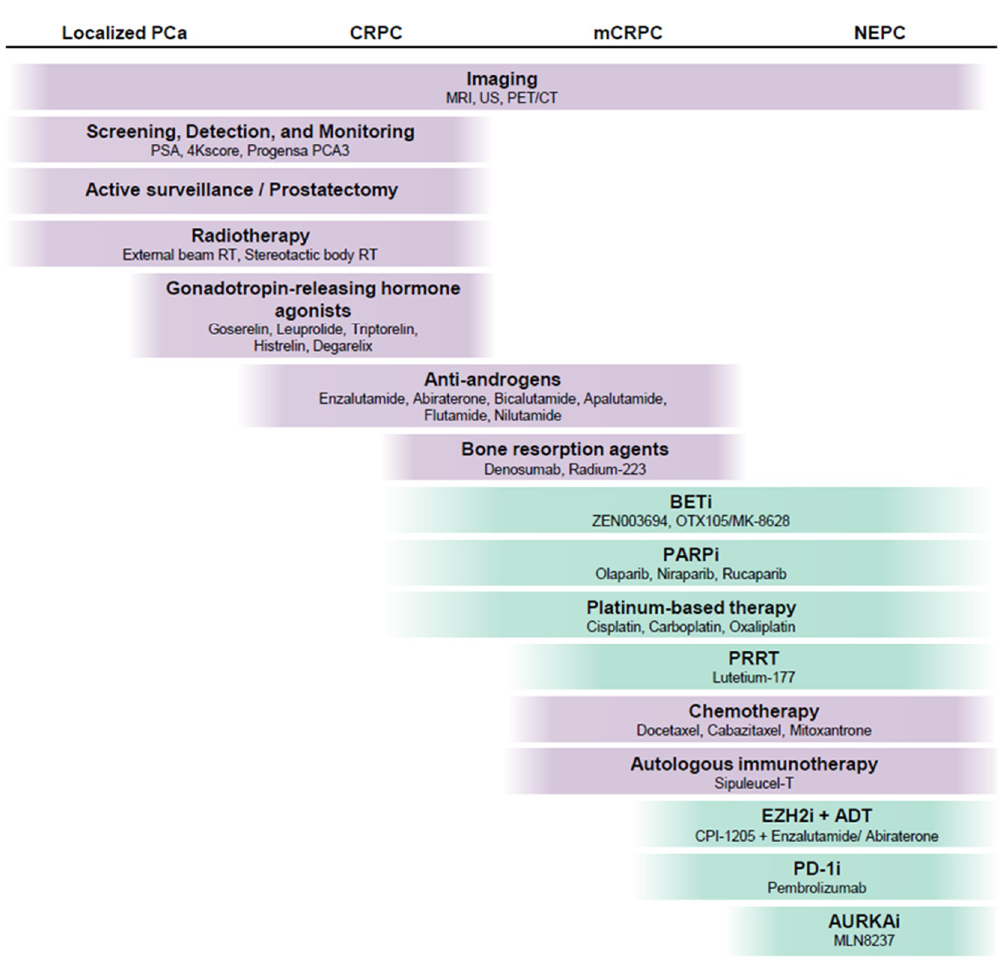
Figure 2. Management options with selected therapeutic agents for localized and advanced prostate cancer. Purple bars denote treatments with regulatory approval; green bars denote therapeutic agents in clinical trials. PCa = prostate cancer; CRPC = castrate-resistant PCa; mCRPC = metastatic CRPC; NEPC = neuroendocrine PCa; MRI = magnetic resonance imaging; US = ultrasound; PET/CT = positron emission tomography/computed tomography; BETi = BET inhibition; PARPi = PARP inhibition; EZH2i = EZH2 inhibition; PD-1i = PD-1 inhibition; and PRRT = peptide receptor radionuclide therapy.